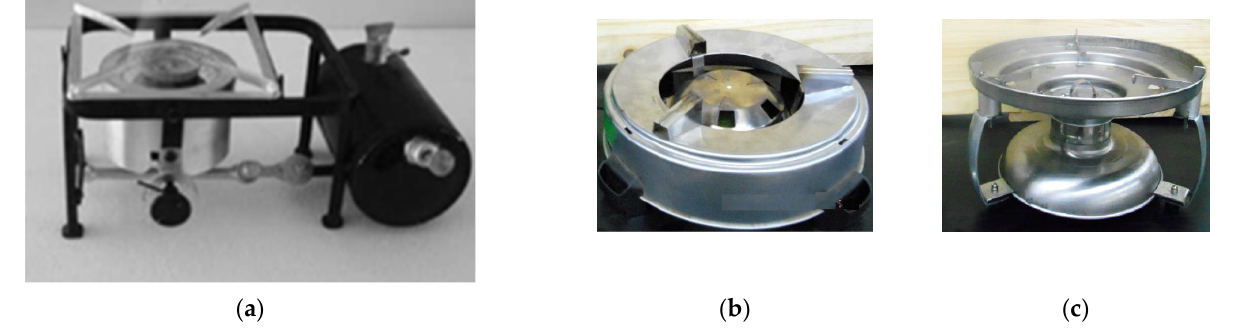
Figure 11. Alcohol cook-stoves. ( a ) NARI ethanol stove [65]; ( b ) Ethanol gel stove [66]; ( c ) Methanol stove [66].